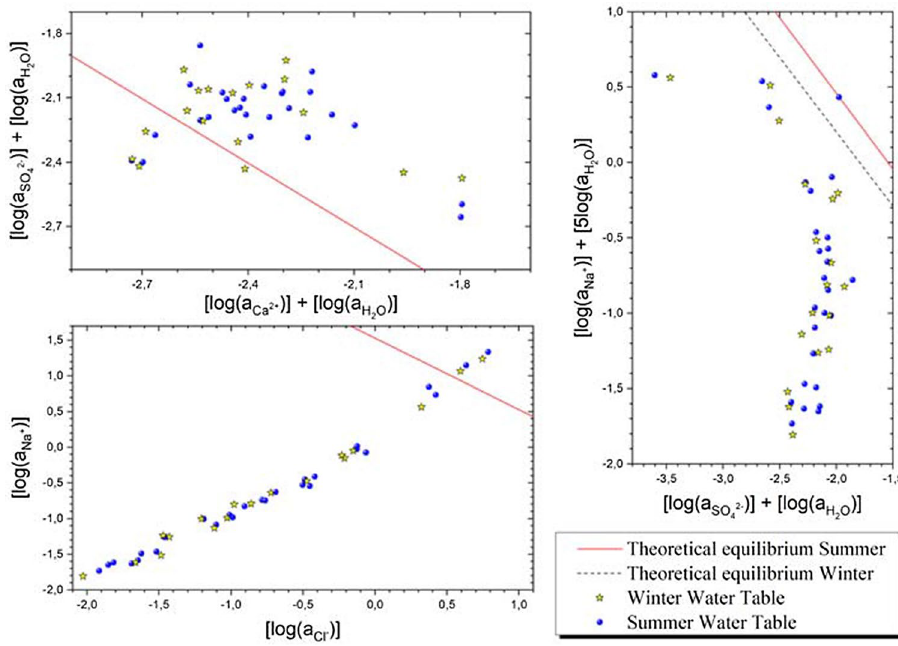
Fig. 5 Relationship between ion activity [log (ax)] for sulfated and chlorinated